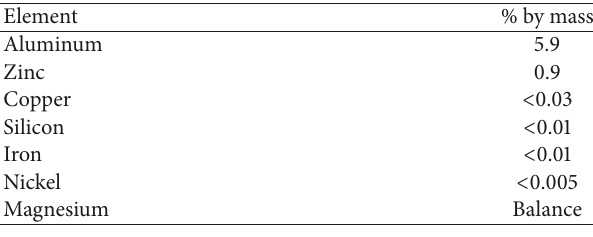
Figure 2: Test rig for measuring surface roughness Ra ( 𝜇